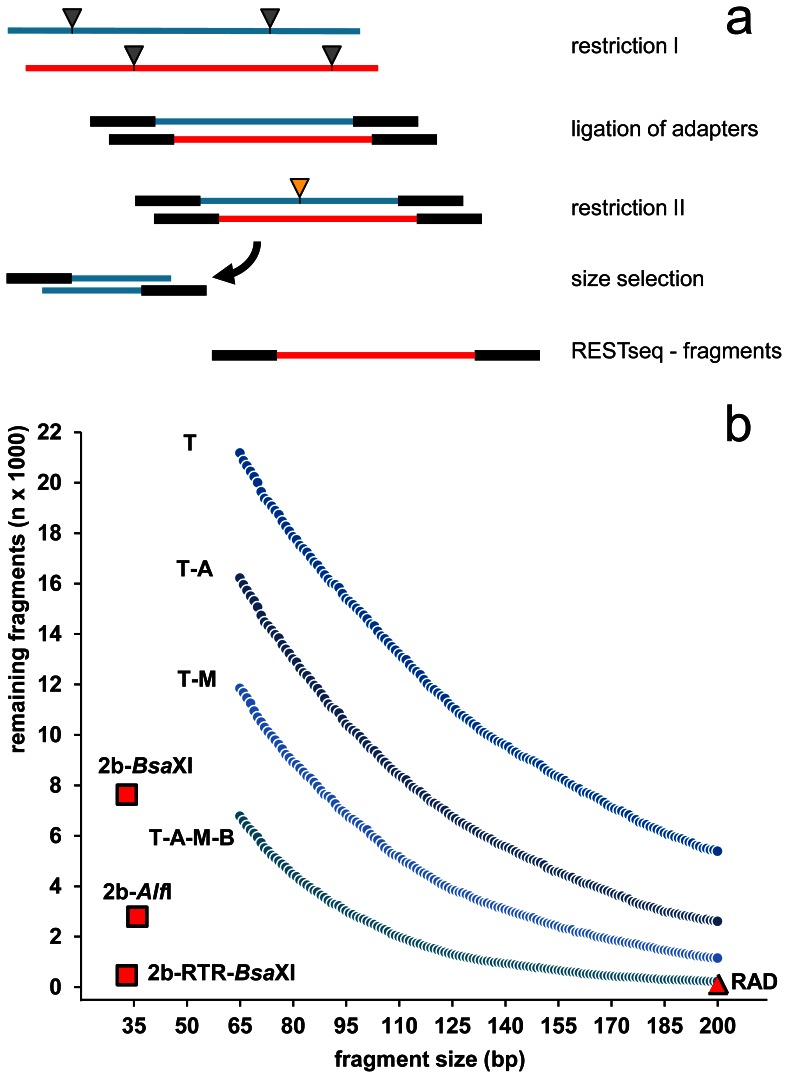
Principle of RESTseq library preparation and the relationship between selected fragment size, chosen restriction endonucleases, and remaining fragment number.(a) Library preparation is accomplished by restriction I, ligation of sequencing adapters, restriction II and then size selection. (b) Illustration of the possible reduction of fragment number and thus library complexity by selecting either longer fragments or by the choice of restriction endonuclease combinations. Shown are expected fragment numbers from A. mellifera LG1 (29.9 Mbp) when choosing fragment size ranges of 20 bp (+/−10 bp around the selected size) and using TaqI (T, TˆCGA) for restriction I in combination with either ApoI (A, RˆATTY) or MseI (M, TˆTAA) for restriction II or the combination ApoI/MseI/BstUI (B, CGˆCG). Numbers of the 33 bp and 36 bp long BsaXI and AlfI fragments (2b-RAD [3]) are shown for comparative reasons as well as the number of SbfI fragments (commonly used for RAD sequencing [2], [15]).